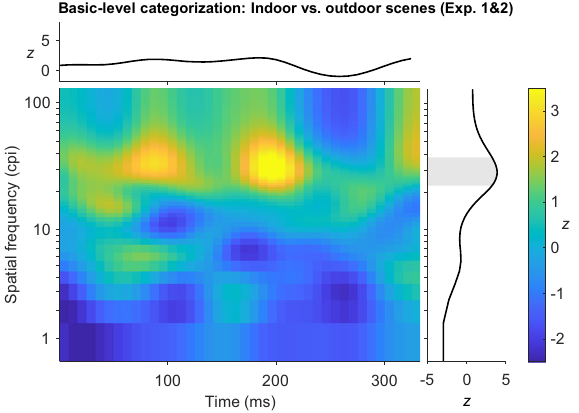
Figure 6. Group classification image obtained for the differences between indoor and outdoor scenes in the SFs sampled across time for the correct basic-level categorization of the respective category. Each pixel indicates how the correlation between the presentation of a spatial frequency at a given point in time and accuracy in the categorization task differs between indoor and outdoor scenes in Experiments 1 and 2 (no significant differences). Line plots at the top and on the right of the classification image show results of the Time- and SF-only analyses. The grey area indicates significant differences between tasks in the sampling of the marked SFs across time. cpi = cycles per